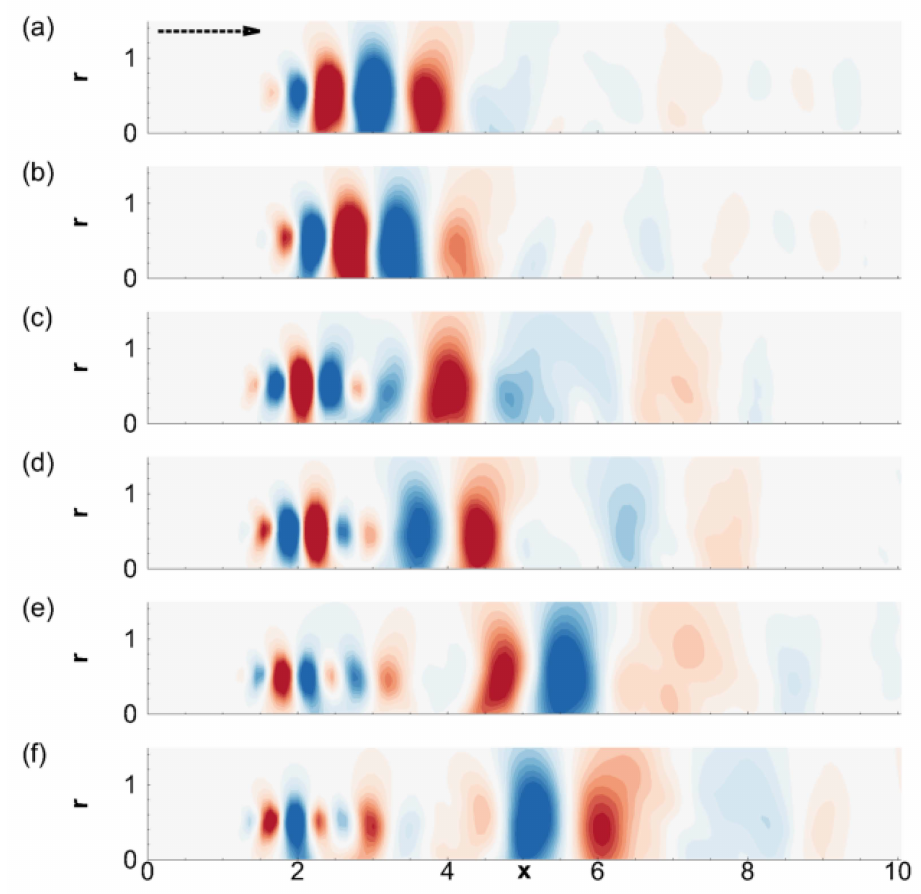
Figure 13. POD modes of the acoustic field, A (cid:48) x . The modes shown are: ( a ) mode 1; ( b ) mode 2; ( c ) mode 3; ( d ) mode 4; ( e ) mode 5 and ( f ) mode 6. The horizontal dotted arrow in ( a ) marks the jet-flow direction. Frames a - f share the same abscissa and